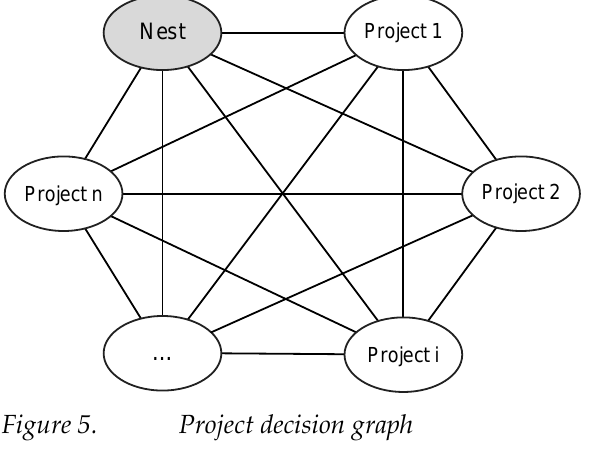
Figure 5. Project decision